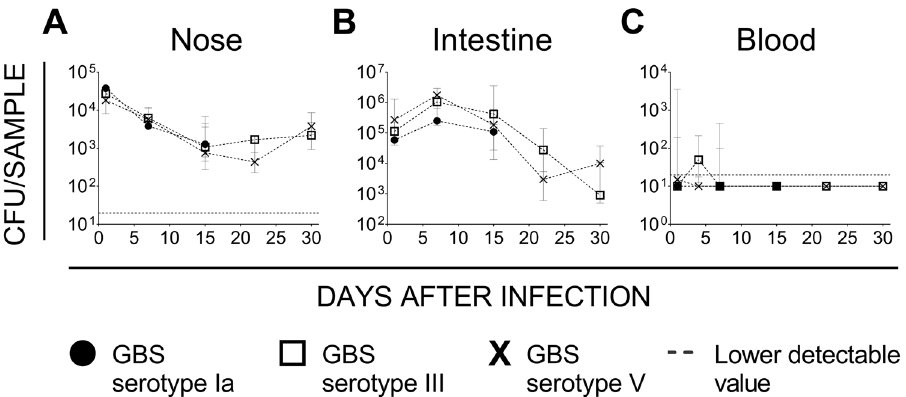
Figure 1. Intranasal infection with GBS resulted in long lasting colonization of nasal and intestinal mucosa and transient bacteremia in mouse neonates. Colony Forming Units (CFUs) enumerated during the time in nasal washes (A) , intestinal homogenates (B) and blood (C) of mouse pups intranasally infected with Group B Streptococcus (GBS) within the first two days of life. Three different GBS strains were tested belonging to serotype Ia (515), III (M781) and V (CJB111). Four to six samples were displayed at each time point from two/ three independent experiments. Each dot represents the median value of the group and the bars depict 25 and 75 percentiles. In panels (A,C) , the dotted grey line is the lowest detectable value.